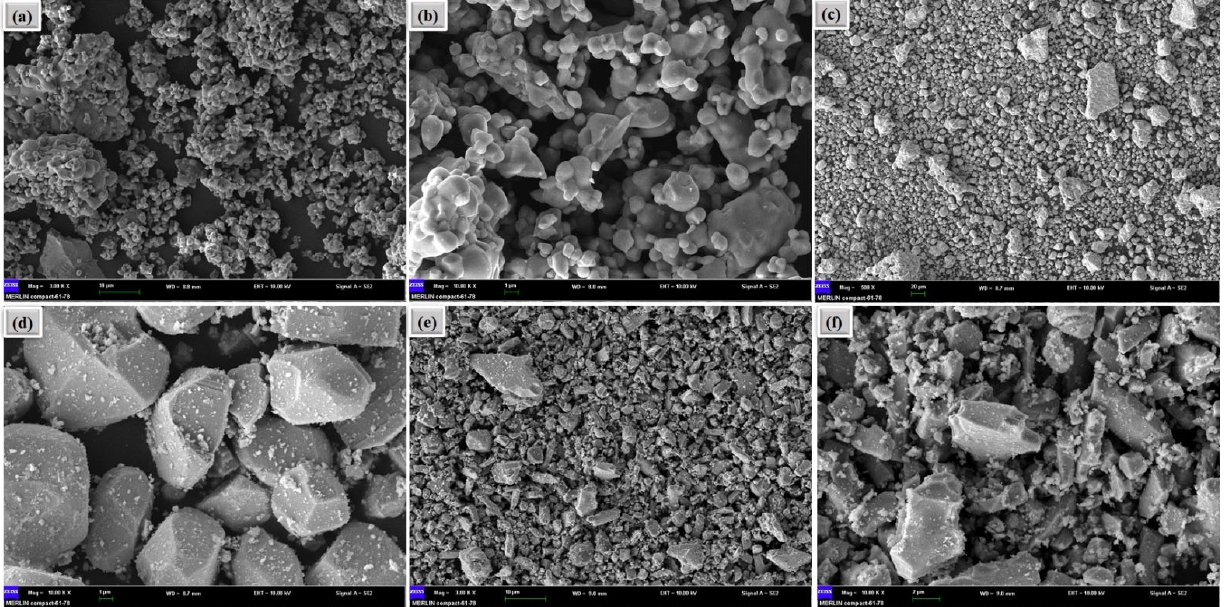
Figure 2. ( a , b ) The surface morphology studied by SEM for CaFe 2 O 4 powers, ( c , d ) SEM image for the commercially purchased WO 3 and ( e , f ) SEM image for WO 3 -CaFe 2 O 4 heterostructure composite powers,